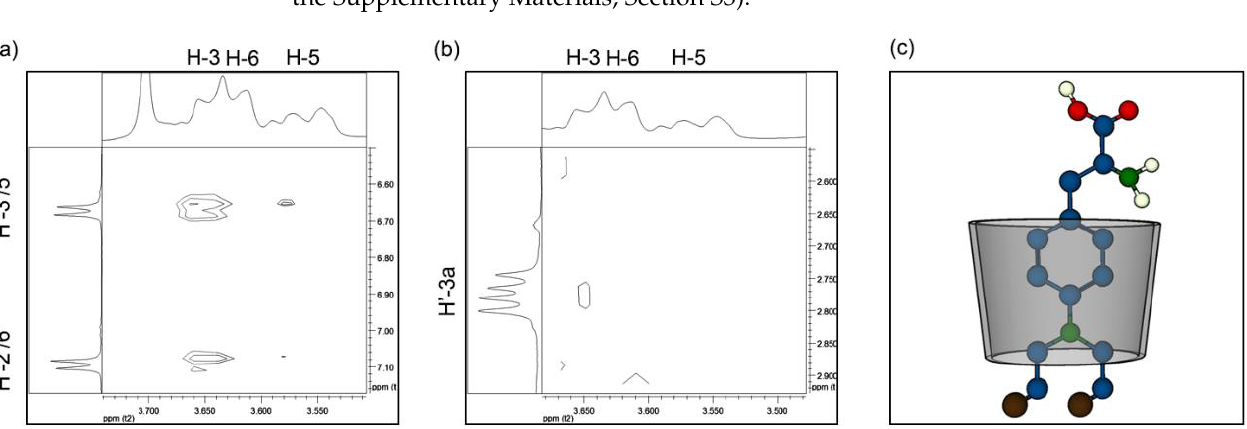
Figure 4. ROESY spectra of the interaction between ( a ) H’ - 2′/6′ and H’ - 3′/5′ of Mel and H -3, H-6, and H- 5 of β CD; ( b ) H’ -3a of Mel and H-3, H-6, and H- 5 of βCD in βCD– Mel complex in DMSO-d 6 ; ( c ) molecular schematic of the proposed inclusion geometry for the βCD– Mel system.